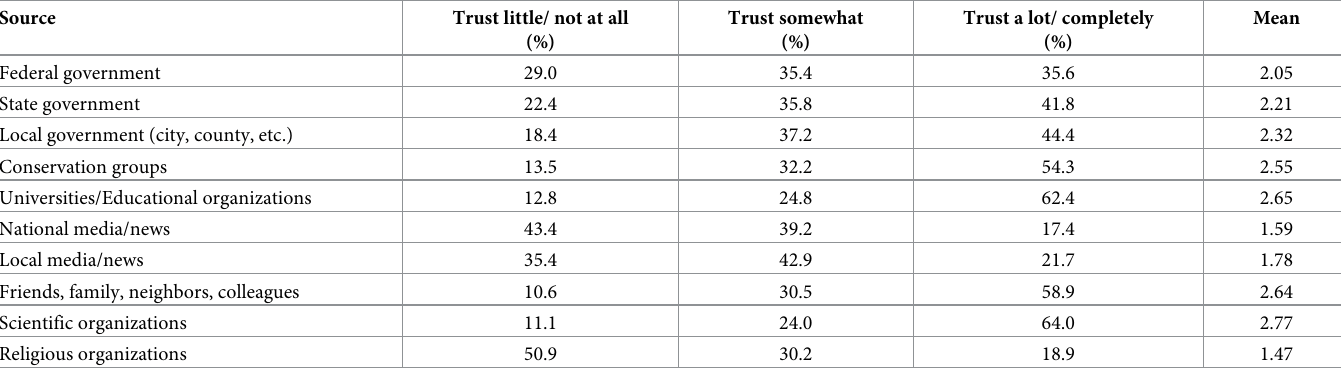
Table 6. Trust in sources for information on nature-related topics.